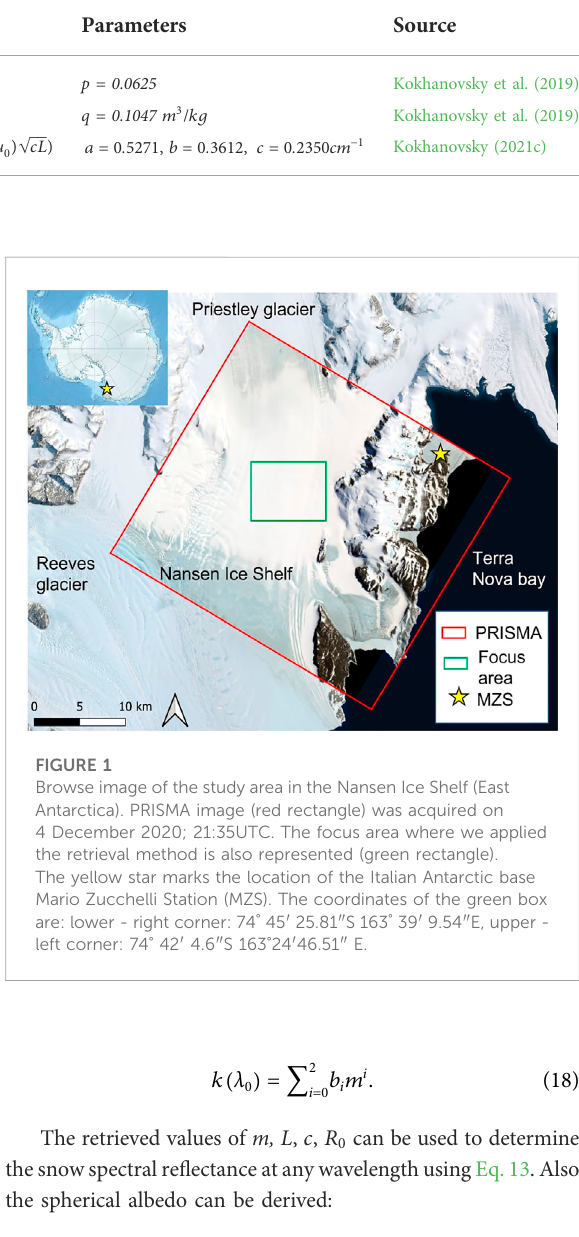
The retrieved values of m, L , c , R 0 can be used to determine